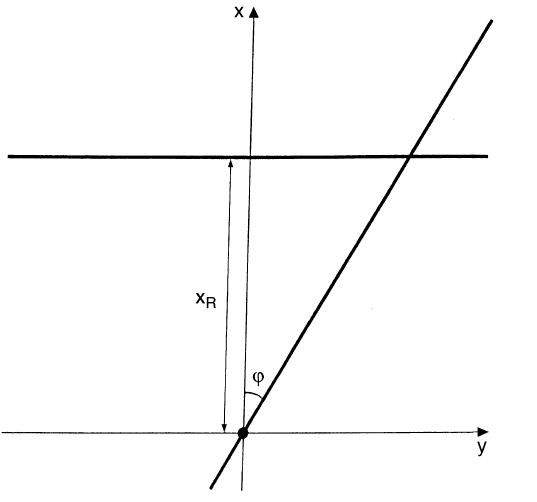
Fig. 1. The location of the ULF finder ( point at the origin of the coordinates) relative to the projection of the oscillating magnetic shell onto the ground ( horizontal line ). The inclined line indicates the direction of wave propagation in the ionospheric wave guide